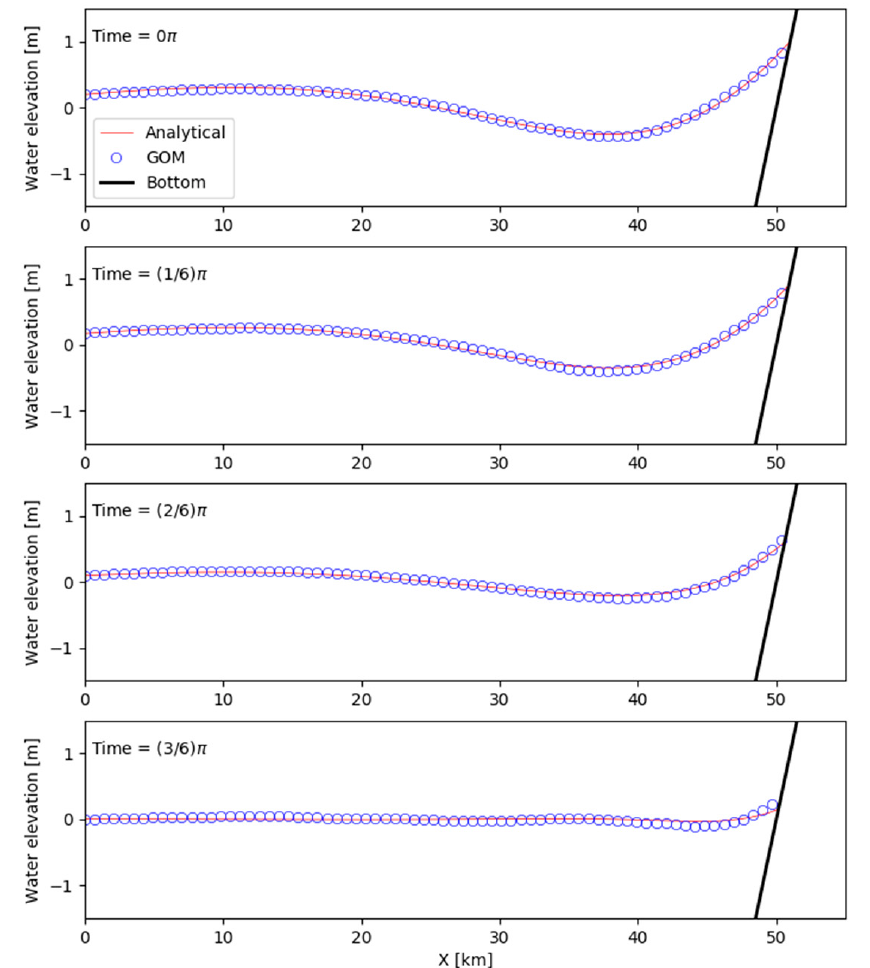
Figure 15. Comparison of wave profiles as predicted by theory (solid red lines) and numerical model (blue circles) of wetting and drying at time = 0 to 𝜋 /2.